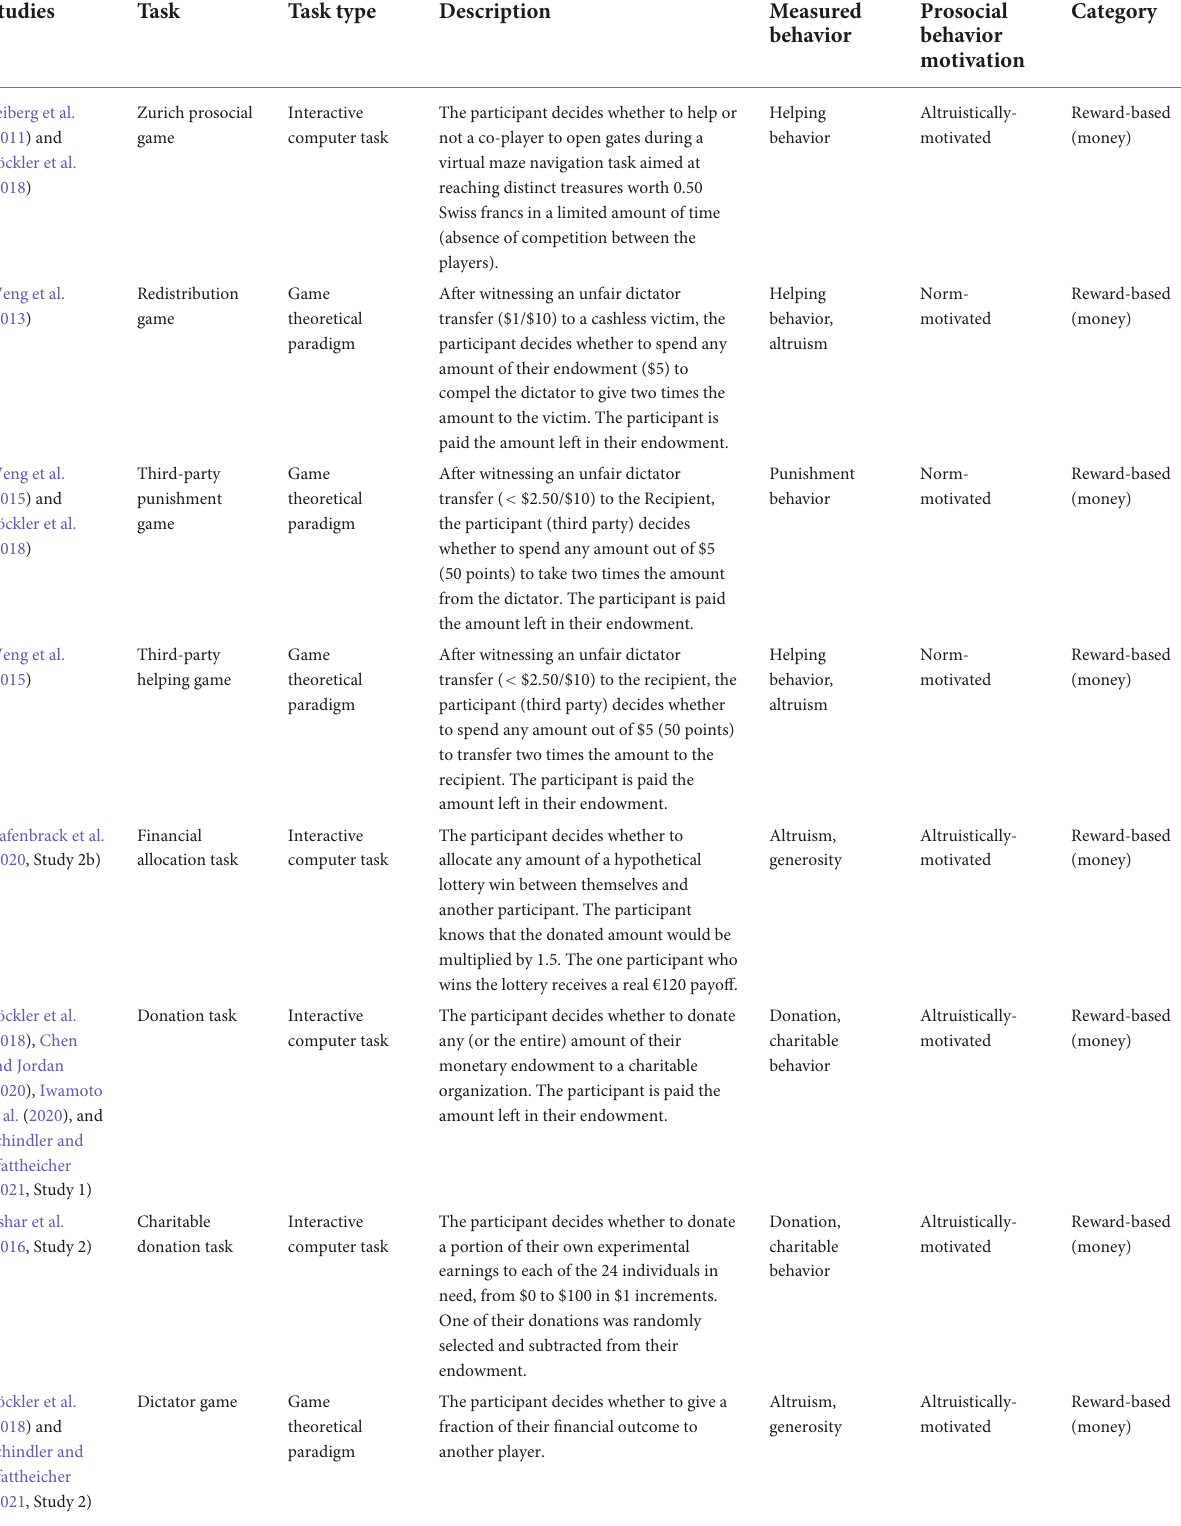
TABLE 2 Description and categorization of the tasks employed in the studies reported in the perspective